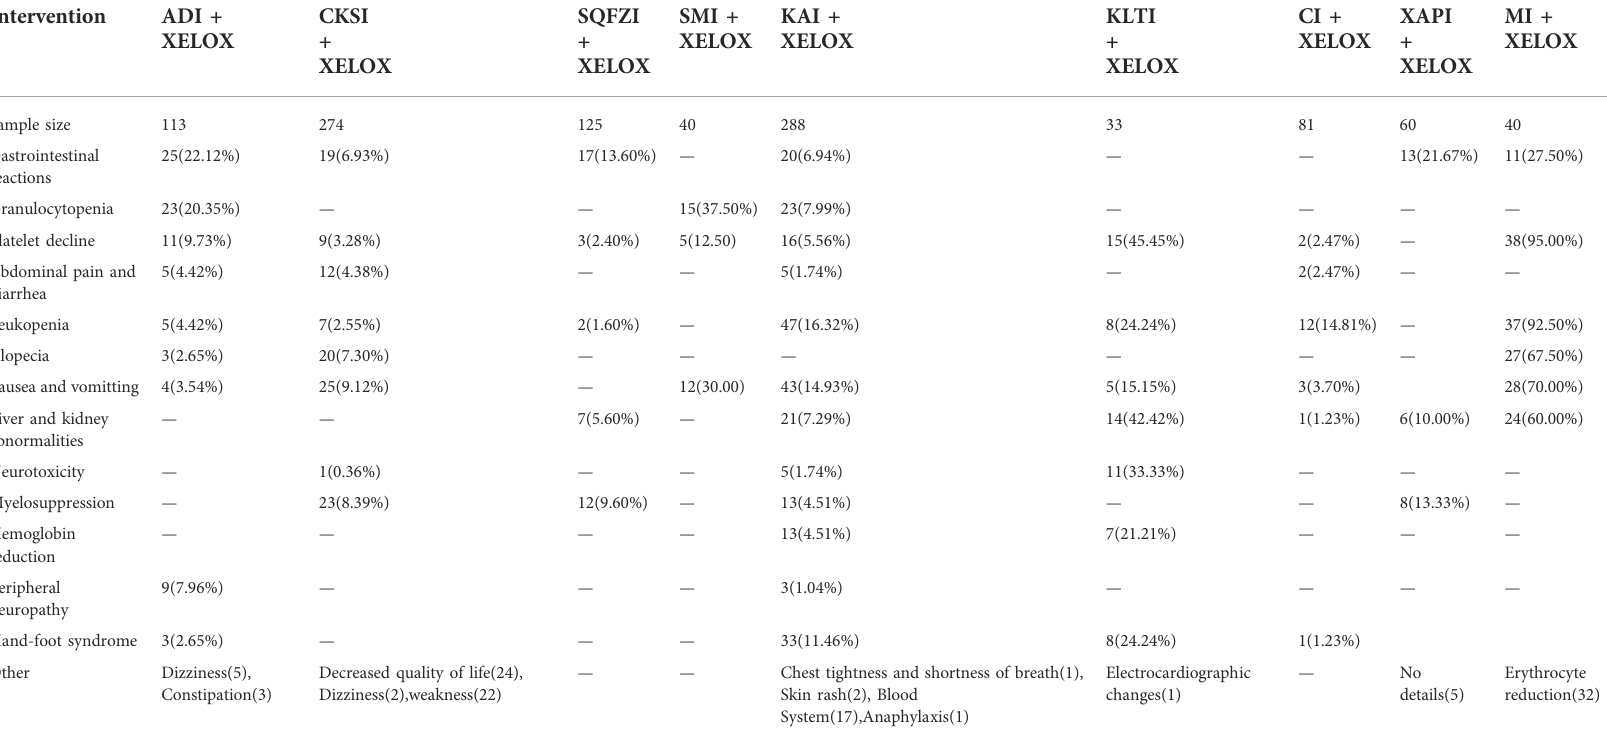
TABLE 8 Summary of results of adverse events for all interventions.The numberis the number of people with various adverse reactions. Case (%). Intervention ADI + XELOX